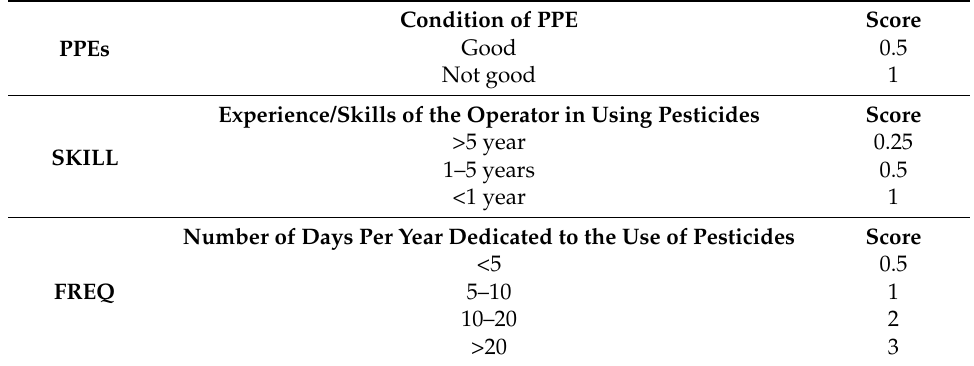
Table 7. Exposure factors related to the condition of PPE, the operator’s experience, and the application